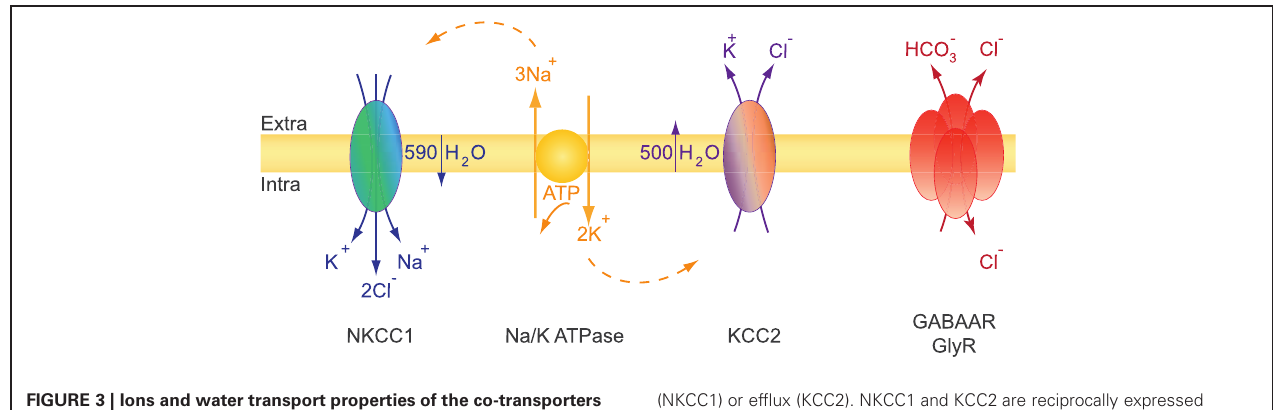
FIGURE 3 | Ions and water transport properties of the co-transporters NKCC1 and KCC2. The secondary active transporters NKCC1 and KCC2 use the energy of the electrochemical Na + and K + gradients generated by the primary active transporter Na-K ATPase to trigger a net inflow of 1K + , 1Na + , 2Cl − , and a net outflow of 1K + , 1Cl − ions, respectively. The activity of each transporter is associated with water influx